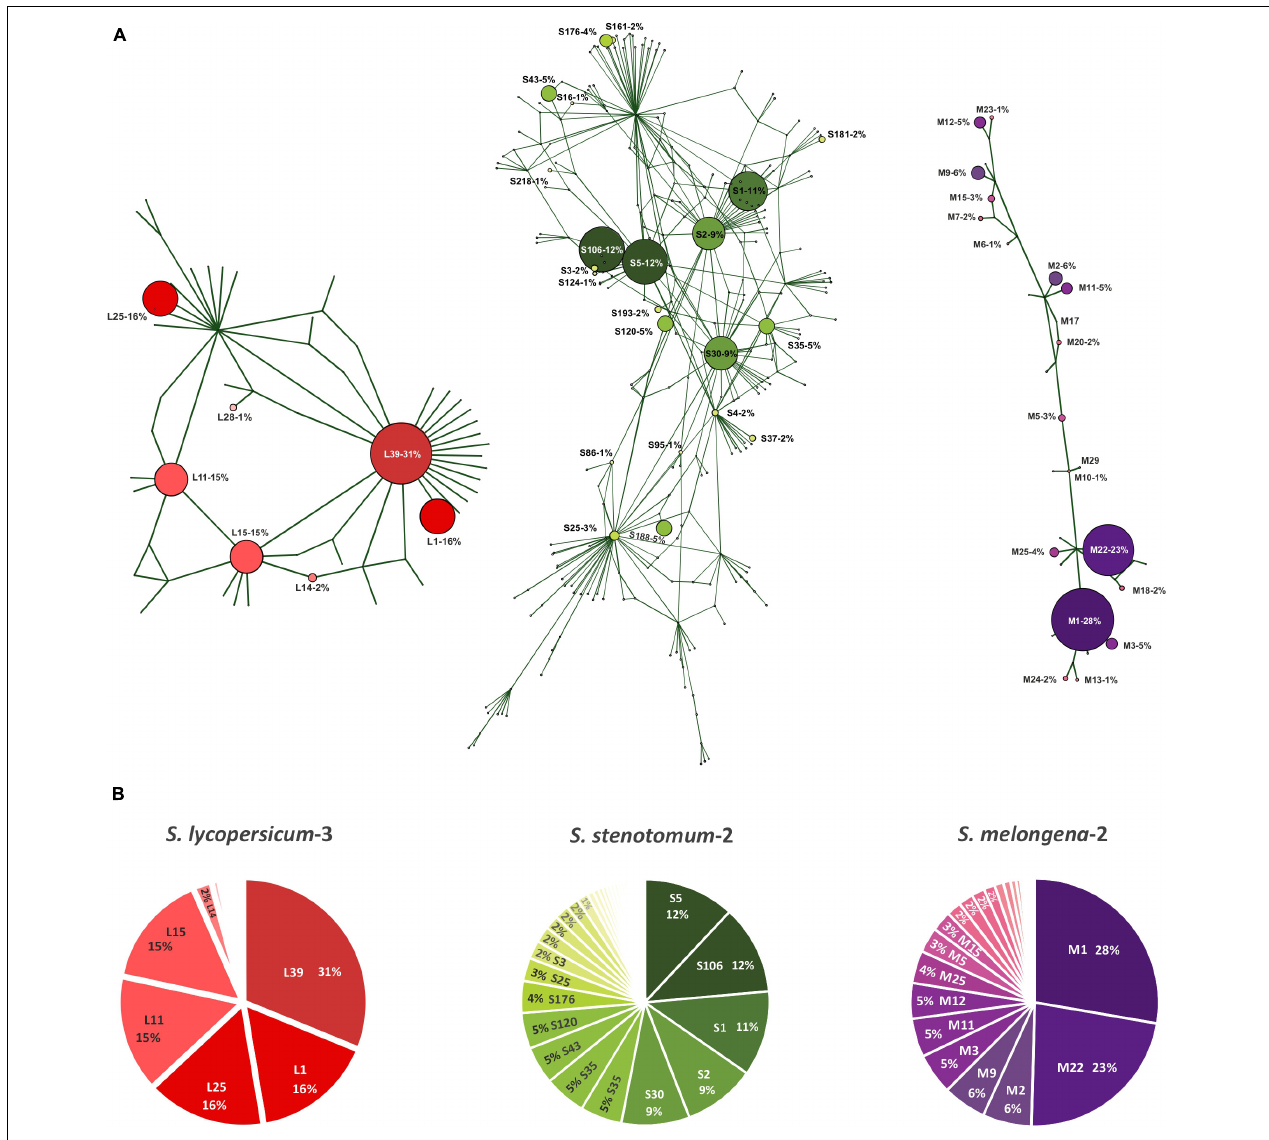
FIGURE 1 | Analysis of 5S rDNA intragenomic diversity in diploid Solanum species. (A) Median joining networks for IGS types/variants (ribotypes) of S. lycopersicum-3 , S. stenotomum-2 , and S. melongena-2 . Ribotypes are designated by the first letter of corresponding species name with index numbers. The size of the circles is proportional to the relative content (in %) of each ribotype in the genome. (B) Relative content (in %) of ribotypes.